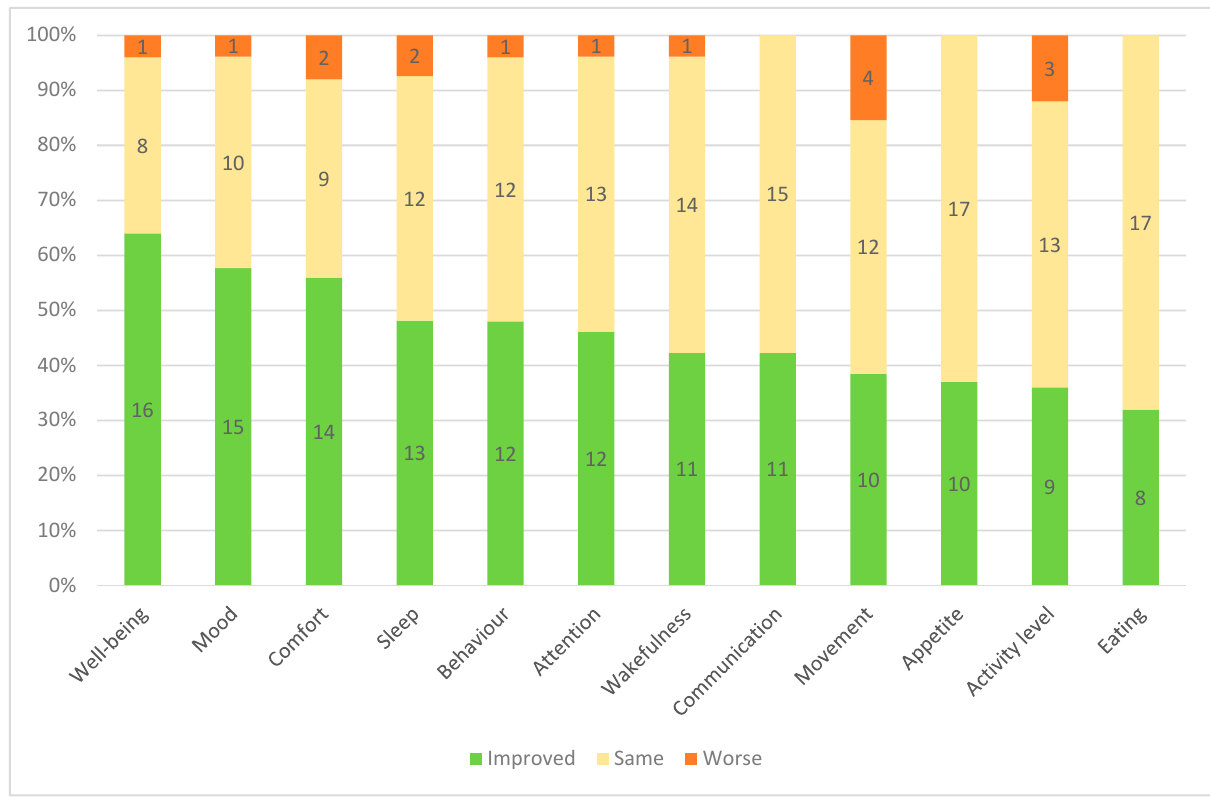
Figure 1. Stacked bar chart of the effects of adaptive sports on each domain ranked from the most to least positive effect.